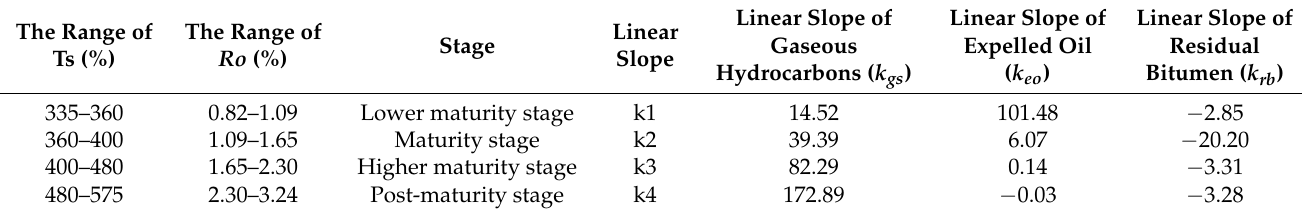
Table 2. The slope to the curve of increased hydrocarbons yield ( kn